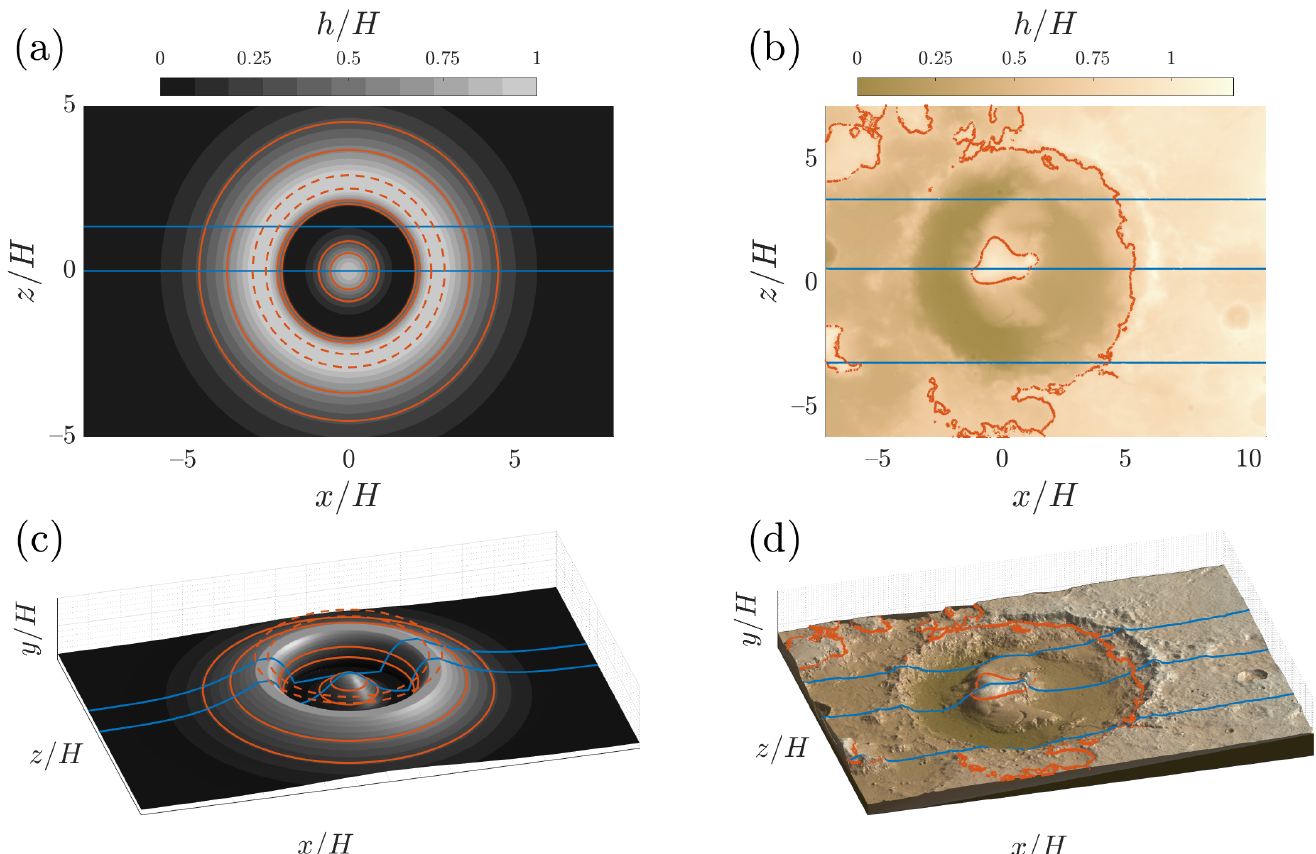
Figure 3. Elevation maps of ( a ) the idealized crater model and ( b ) the Gale Crater model. ( c , d ) Isometric views of the idealized and Gale Crater models, respectively. Solid red lines demarcate the intersections of the wall-parallel PIV measurement planes with the surface, and the blue lines identify the spanwise positions of the wall-normal PIV measurement plane locations. H is the model elevation, corresponding to the rim